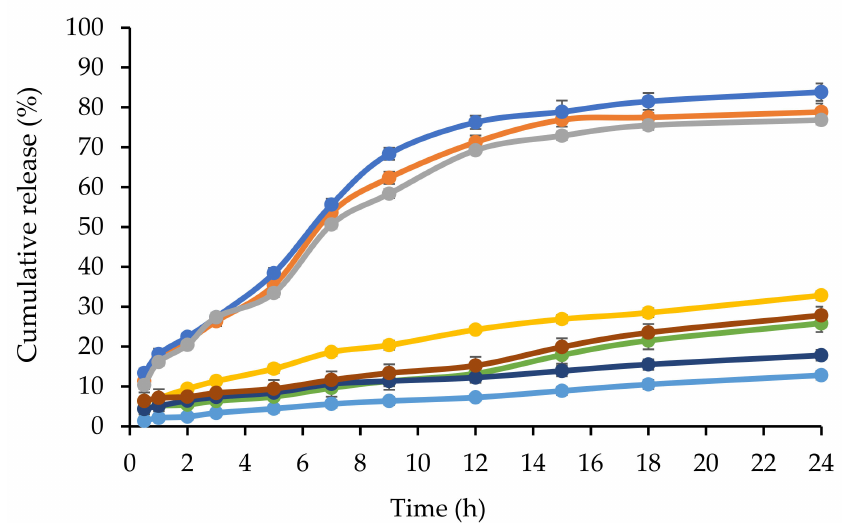
Figure 4. Dissolution profiles at 37 ◦ C during 24 h of CL in simulated gastric fluid (SGF pH = 1.2, • ), simulated extracellular tumor cells fluid (ETC, pH 5.5, • ), simulated intestinal fluids (SIF, pH = 6.8, • ) and simulated colon fluid (SCF, pH = 7.4, • ) and CL from CL-loaded NBSCh micelles in SGF pH 1.2